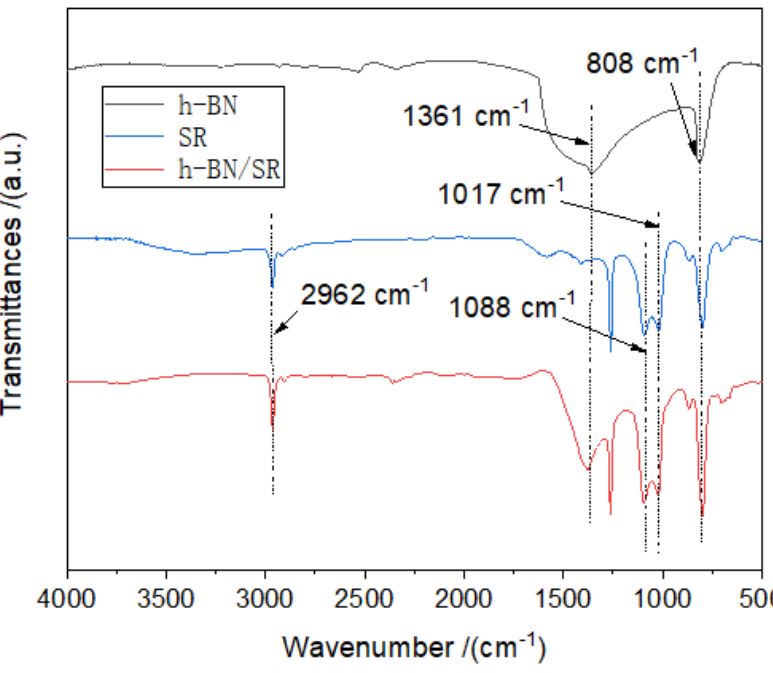
Figure 4. FTIR curves of h-BN, SR, and h-BN/SR.